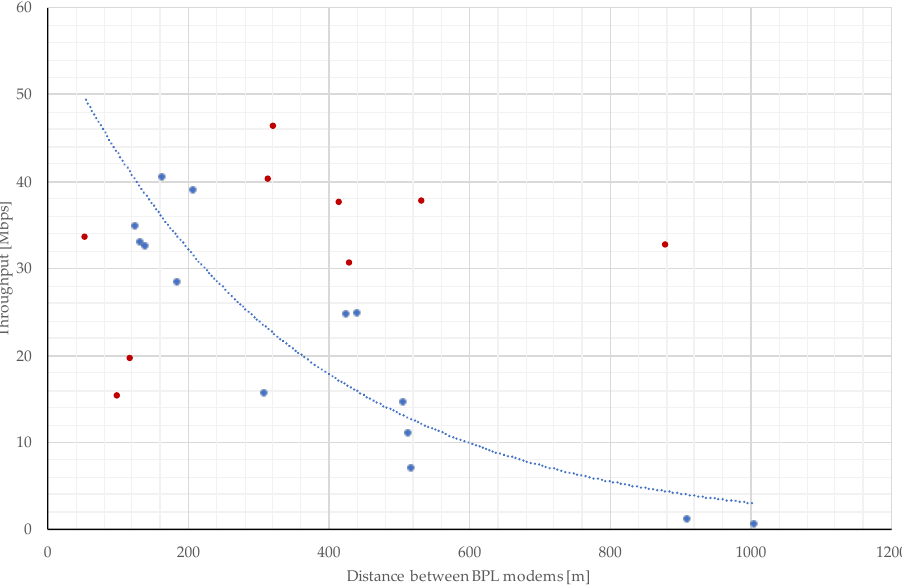
Figure 1. The trend in transmission control protocol (TCP) throughput depending on communication distances between BPL modems on MV